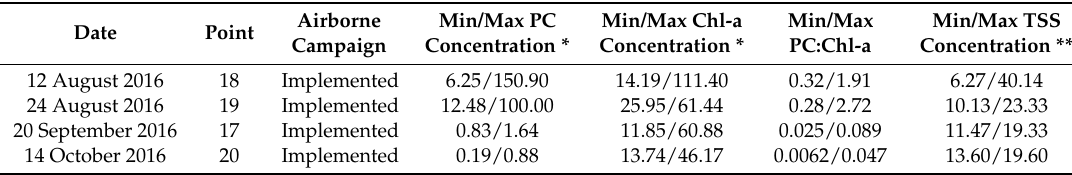
Table 1. Monitoring and experimental data